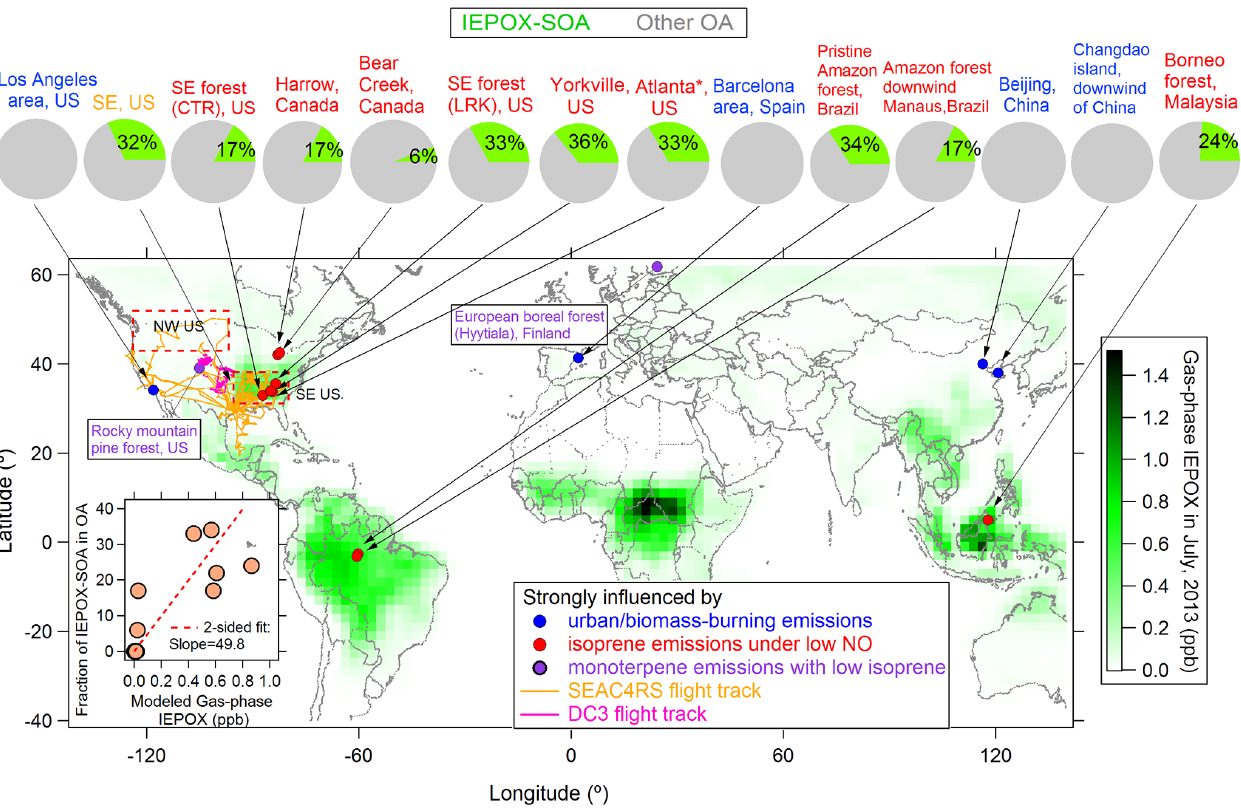
Figure 1. Locations of field campaigns used in this study. The IEPOX-SOA fractions of OA in different studies are shown in the pie charts on the top of graph. Site names are color coded with site types. Detailed information these studies can be found in Table 1. Note that the Atlanta pie chart was averaged by three urban data sets in Budisulistiorini et al. (2013) and Xu et al. (2015). The green background is color coded with modeled global gas-phase IEPOX concentrations for July 2013 from the GEOS-Chem model. The insert shows as scatter plot of observed average fraction of IEPOX-SOA in OA vs. GEOS-Chem modeled gas-phase IEPOX in various field